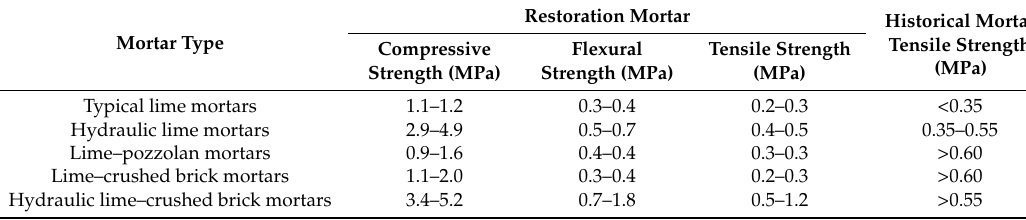
Table 6. Mechanical properties of restoration mortars after nine months of hardening according to Moropoulou et al. [231] and of historical mortars of each type